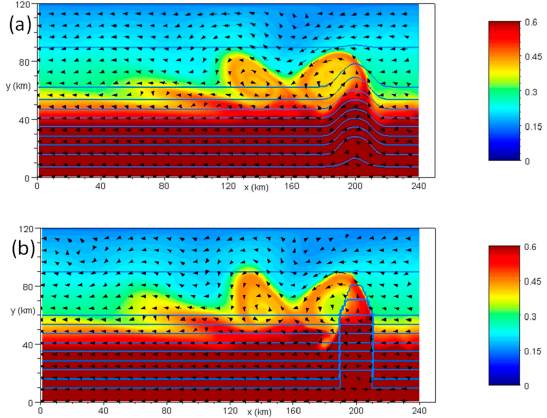
Figure 15. Canyon-upwelling